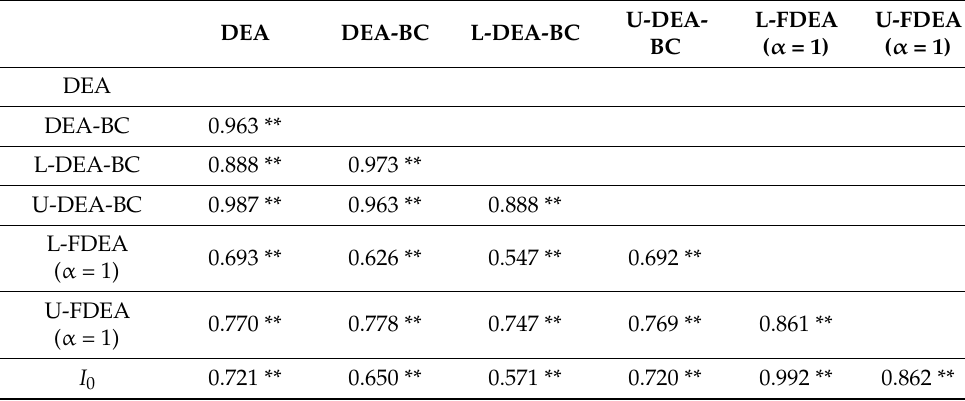
Table 3. Correlation coefficients among different